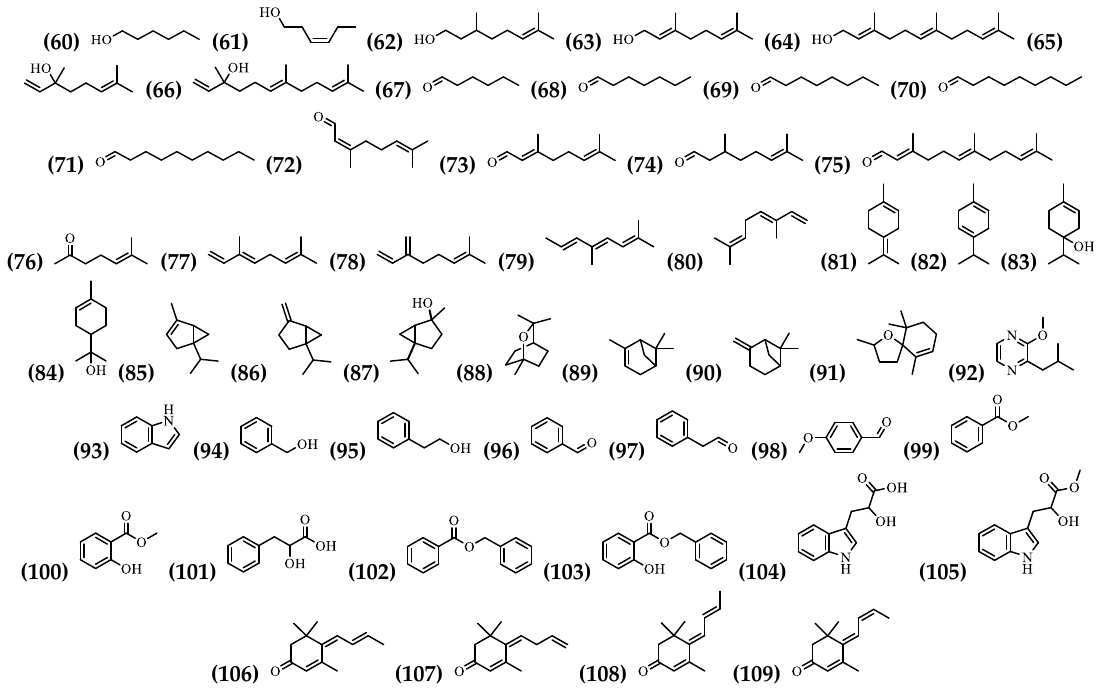
Figure 4. Structure of Volatile Compounds from Brugmansia suaveolens .